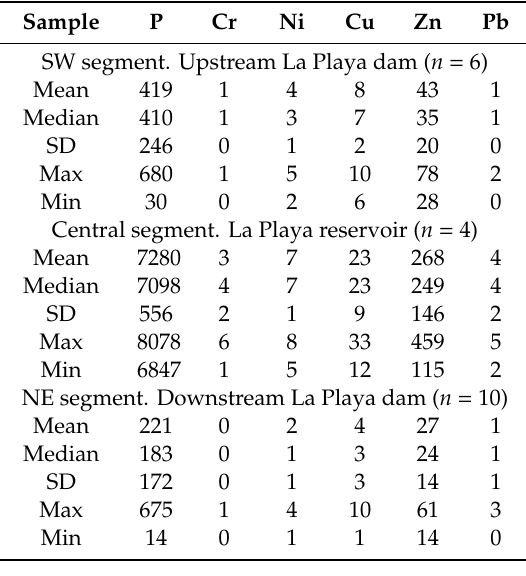
Table 3. Trace element water compositions at the sampling sites determined by ICP-MS (in µ g / L). SD: Standard Deviation; Max: Maximum; Min: Minimum. Complete dataset and field water parameters are available in the Supplementary Materials (Table